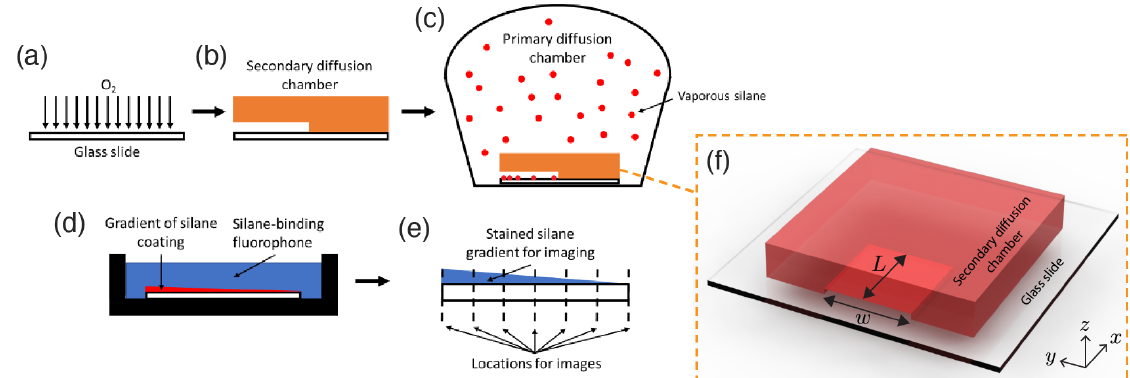
Figure 1. Schematic of gradient aminosilane diffusion and subsequent staining/imaging. ( a ) A clean glass slide is treated with oxygen plasma for 5 min. ( b ) A 3D-printed secondary diffusion chamber (detailed in ( f )) is attached to the plasma-treated side of the surface. This creates one opening for the silane to penetrate into the secondary diffusion chamber. ( c ) The glass slide with secondary diffusion chamber and petri dish containing liquid-phase aminosilane are placed within the primary diffusion chamber. The primary chamber is then placed under vacuum, driving the aminosilane into the vapor phase. The chambers are incubated for a time that is insufficient for the silane to saturate the secondary diffusion chamber. ( d ) After a gradient is formed on the secondary chamber floor, the glass slide is removed from the primary diffusion chamber, detached from the secondary chamber, and incubated with an amine-specific fluorophore. Due to the monolayer nature of the silane coating, the resultant gradient is in the molecular surface coverage per unit area, and is depicted in this step as a continuous curve. ( e ) Linear transverse scans along the slide’s longitudinal axis are conducted every 5 mm. ( f ) Rendering of 3D-printed secondary diffusion chamber on glass